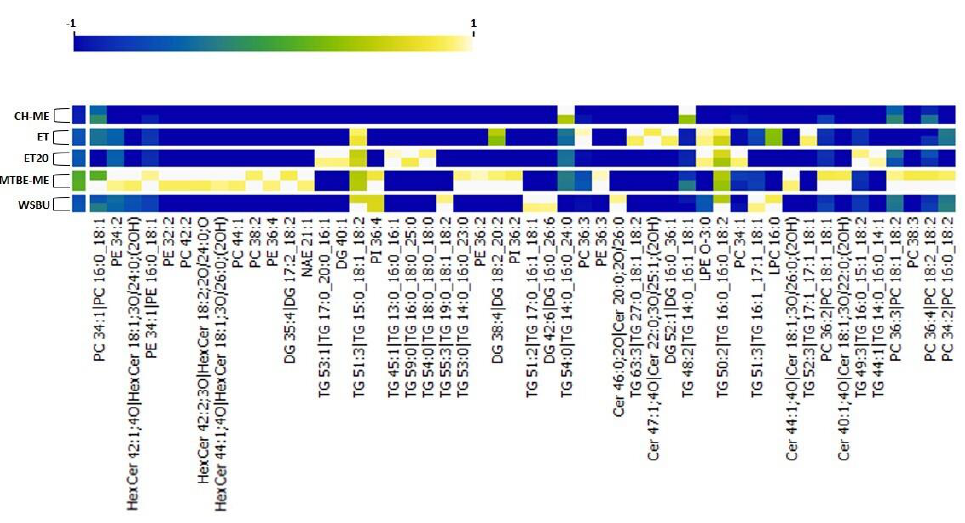
Figure 11. Heat-map of top 50 modulated lipids.